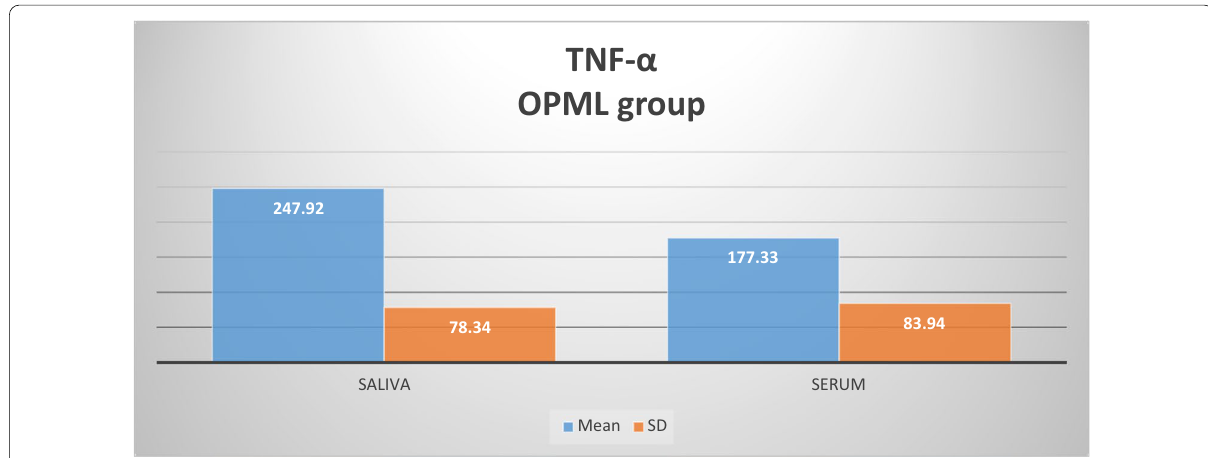
Fig. 6 Bar chart showing mean and standard deviation of TNF-α in saliva and serum in OPML group